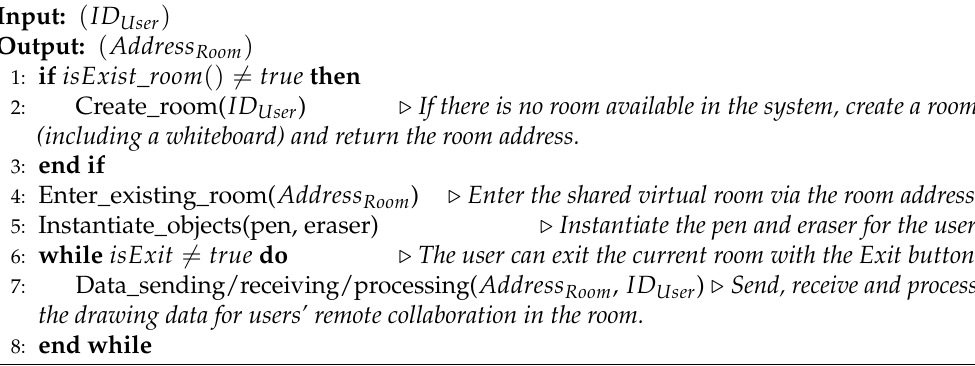
Algorithm 1 The processing flow algorithm of the PUN